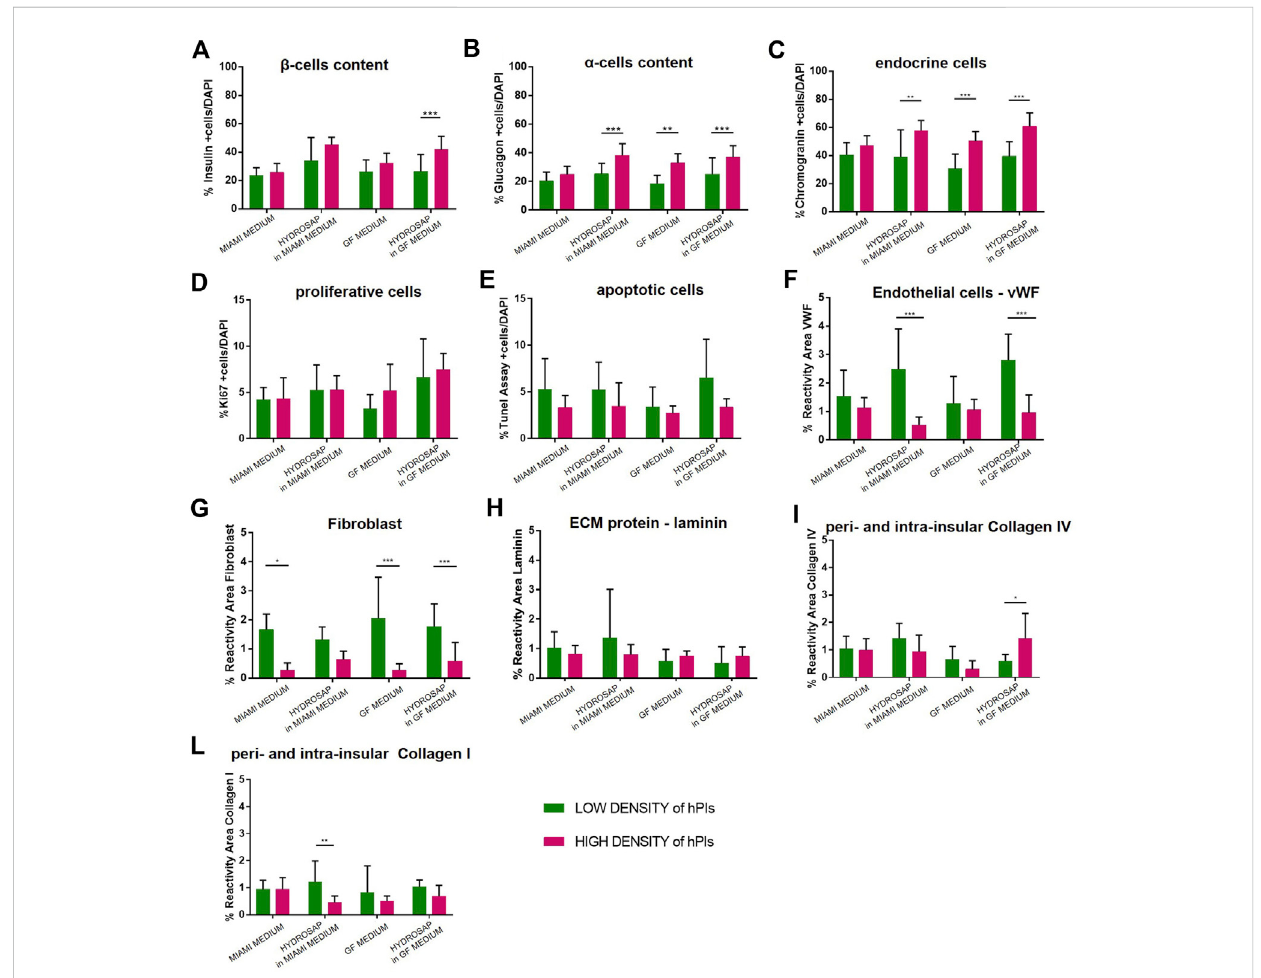
FIGURE 5 Comparison between Low-Density (25IEQ) and High-Density (500IEQ) cultures of hPIs in suspension in MIAMI medium, in suspension in GF medium, embedded in HYDROSAP with MIAMI medium and embedded in HYDROSAP with GF medium after 28-days of culture. hPIs in suspension in MIAMI and GF medium cultured for 28-days are considered as negative controls. Graph shows mean ± SEM of triplicate samples per conditions for percentageof (A) β -cellscontent, (B) α -cellscontent, (C) endocrinecells, (D) proliferativecells, (E) apoptoticcells, (F) endothelialcells, (G) fi broblast, (H) laminin, (I) collagen IV, and ( L ) collagen I, indicating an increased percentage of α -cells, β cells and endocrine fraction, followed by a lower concentration of ECM components. Experiments were performed in triplicate for each condition, and statistical analysis (two-way ANOVA